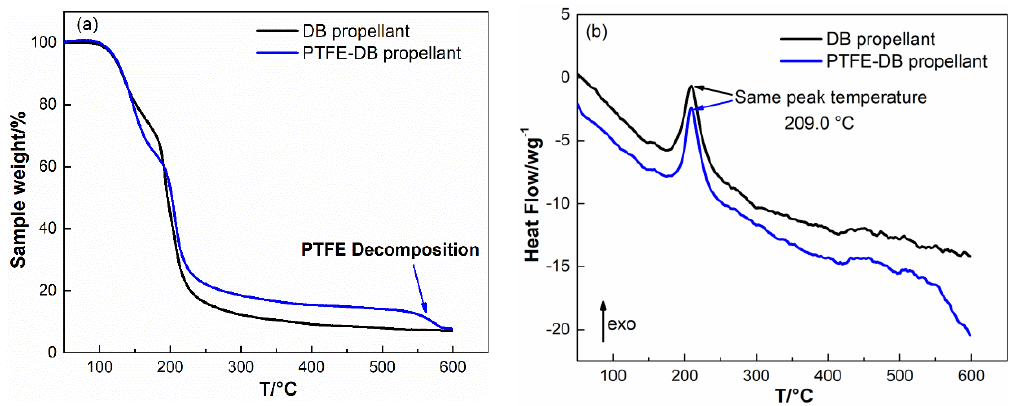
Figure 3. Non-isothermal TG curves ( a ) and DSC ( b ) curves of DB and PTFE-DB propellant.